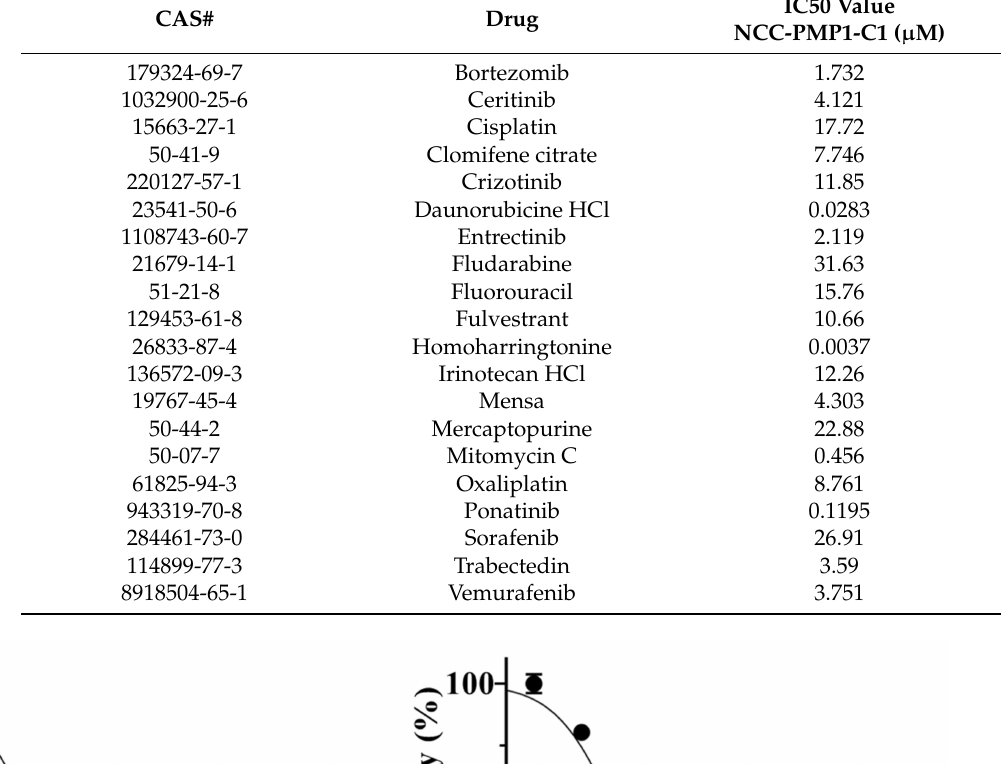
Table 2. List of half-maximal inhibitory concentration (IC 50 ) values in NCC-PMP1-C1 cells.